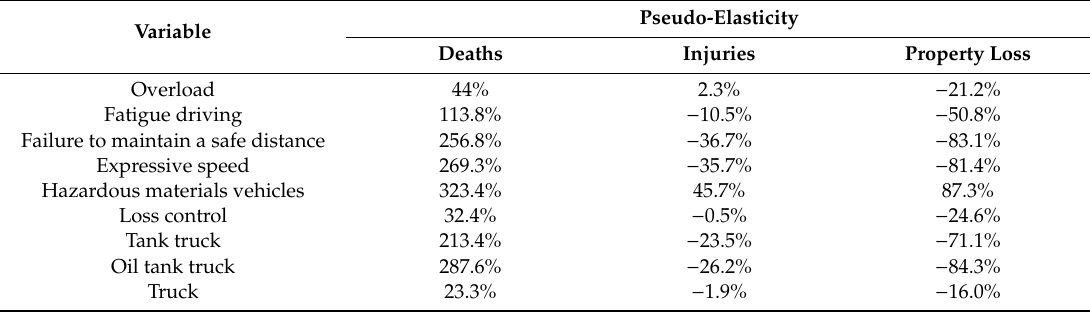
Table 4. Elastic analysis of factors that significantly influence the severity of road hazardous materials transportation